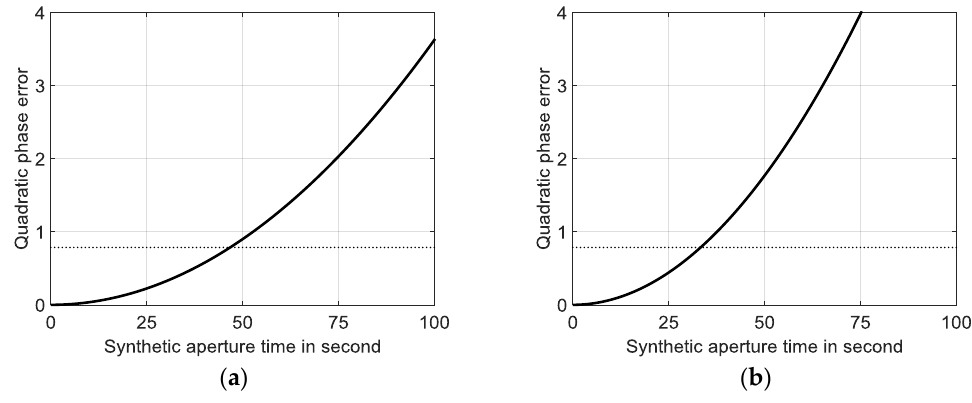
Figure 10. Quadratic phase error caused by the total time delay during an exposure time of 100 seconds with: ( a ) a g 0 − a m = 0 ( b ) a g 0 − a m = π /6.